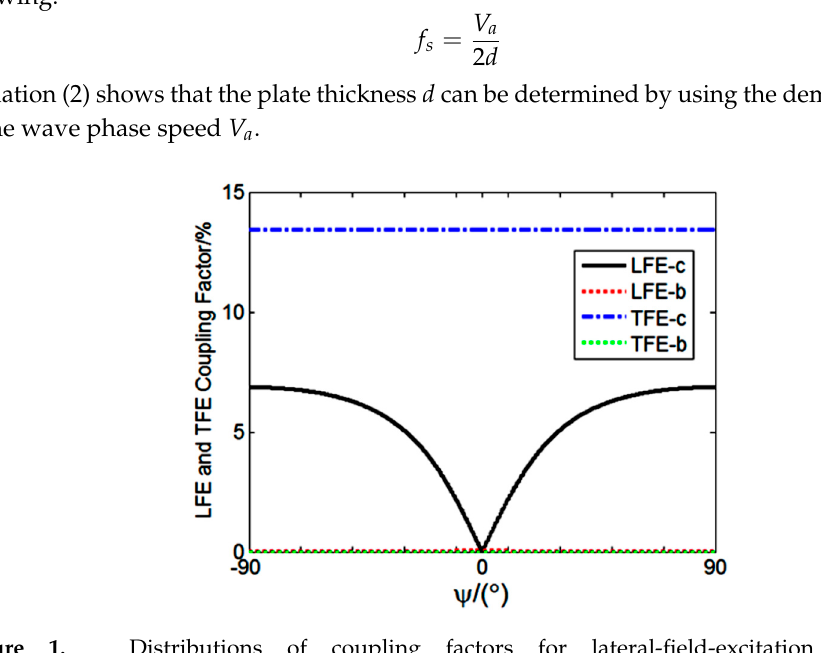
Figure 1. Distributions of coupling factors for lateral-field-excitation (LFE) and thickness-field-excitation (TFE) of (yxl) 13.8° LGT crystals.